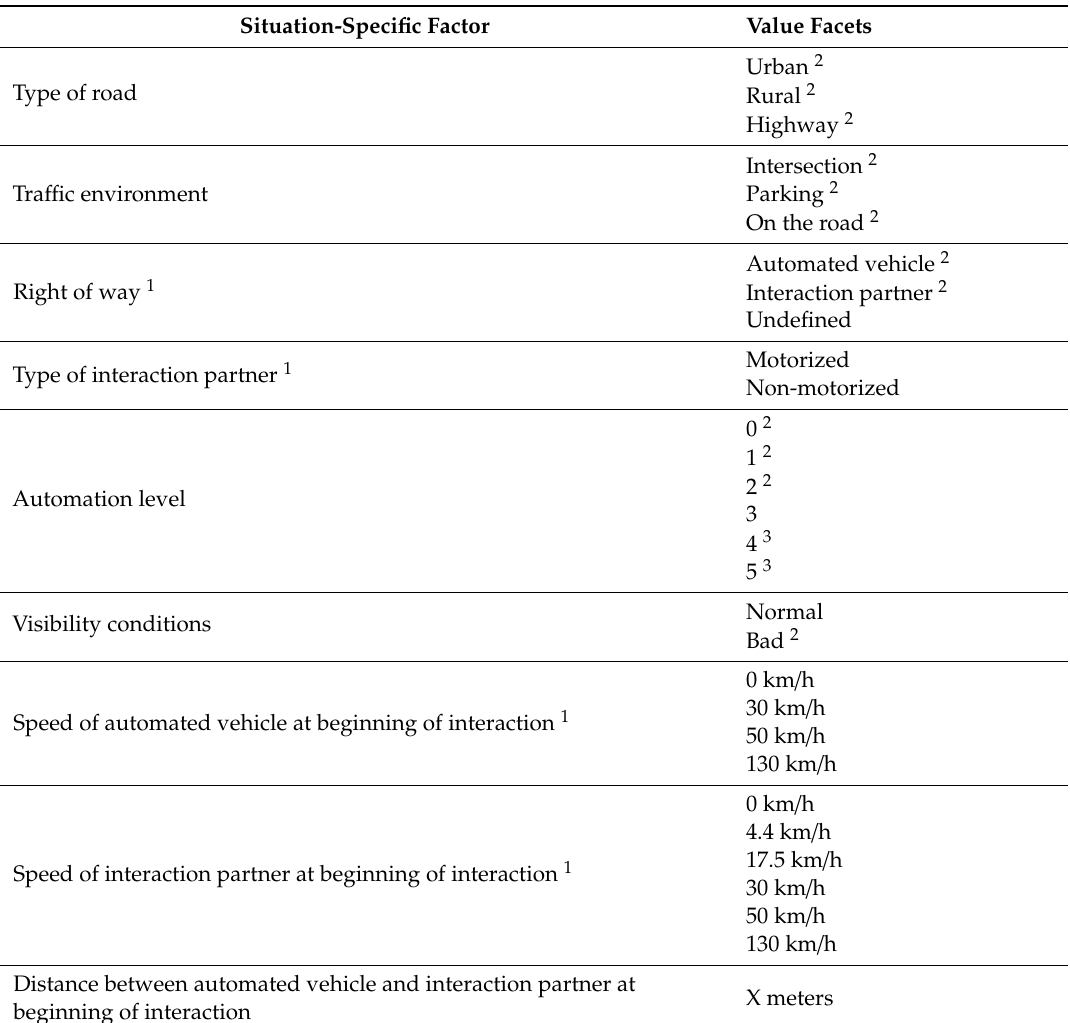
Table 1. Situation-specific factors, their value facets, and the application of Filter